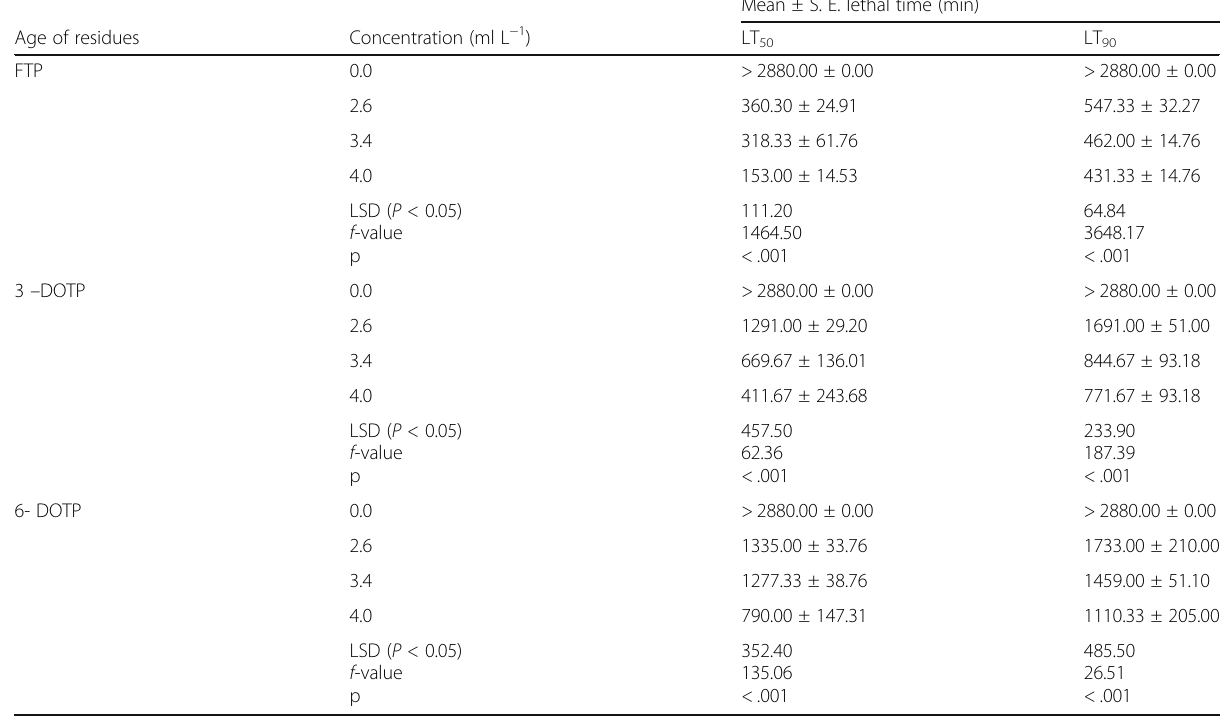
Legend: FTP freshly treated panels, 3-DOTP 3-day-old-treated panels, 6-DOTP 6-day-old-treated